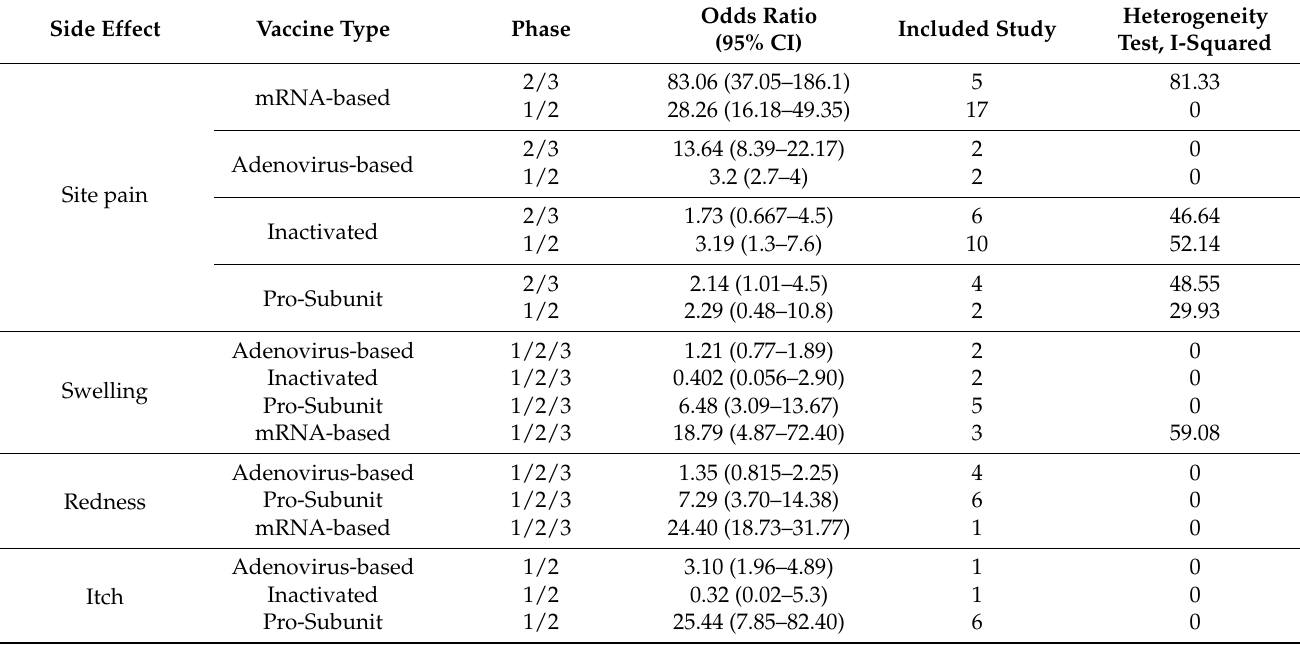
Figure 3 . Local and systemic side effects of different COVID-19 vaccines. Figure 3. Local and systemic side effects of different COVID-19 vaccines. Table 4. Association of side effects with different COVID-19